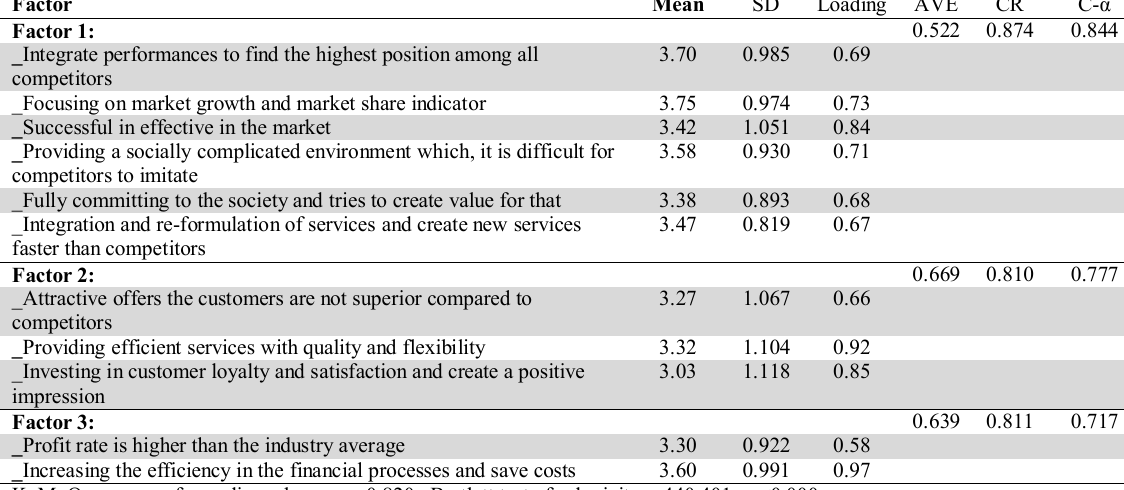
Results of CFA and internal reliability testing & K–M–O measure for SCA